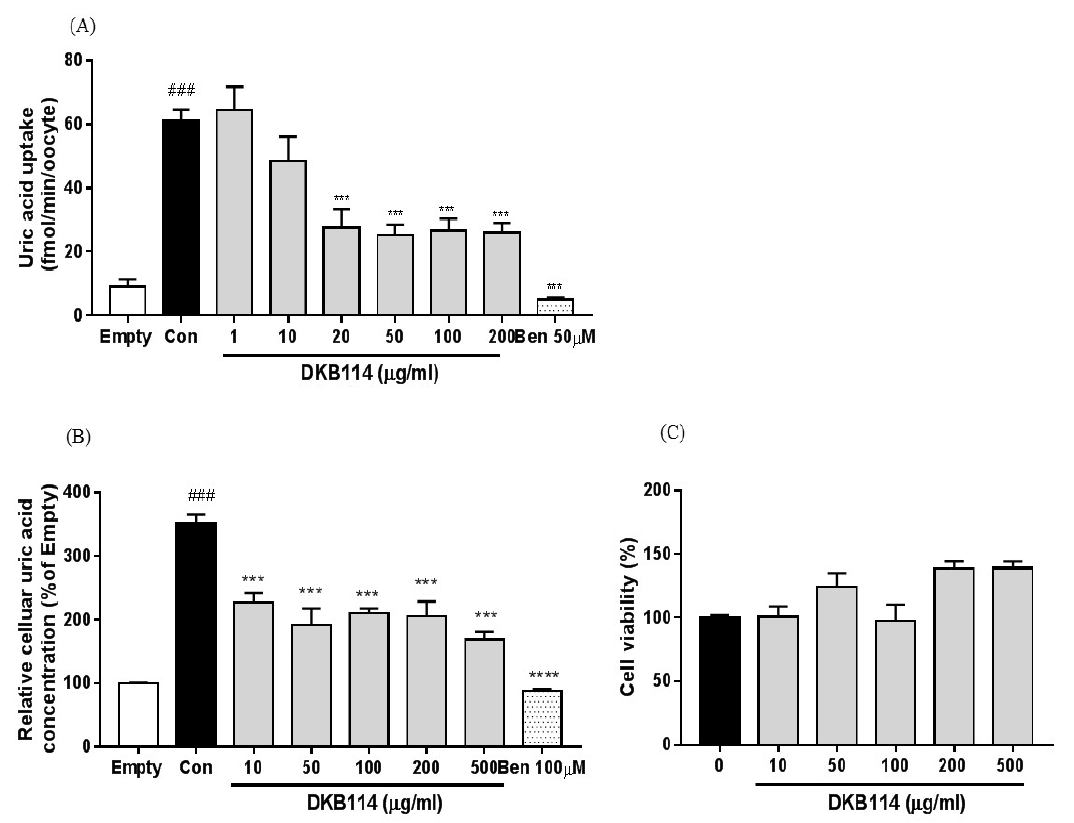
Figure 3. Effects of DKB114 on uric acid uptake in hURAT1-expressing oocytes and HEK293 cells. ( A